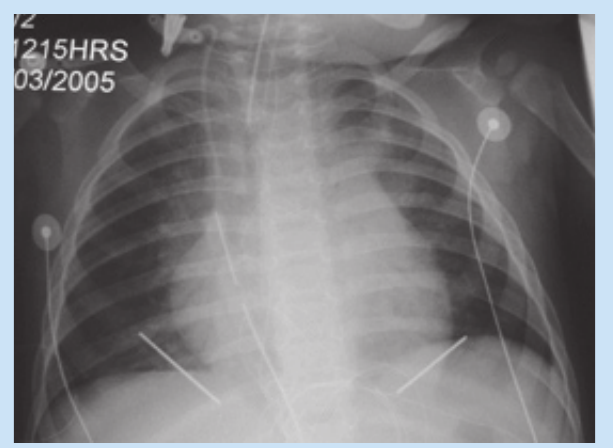
Fig. 1. Identification of the variety of lines and tubes and adequate positions for